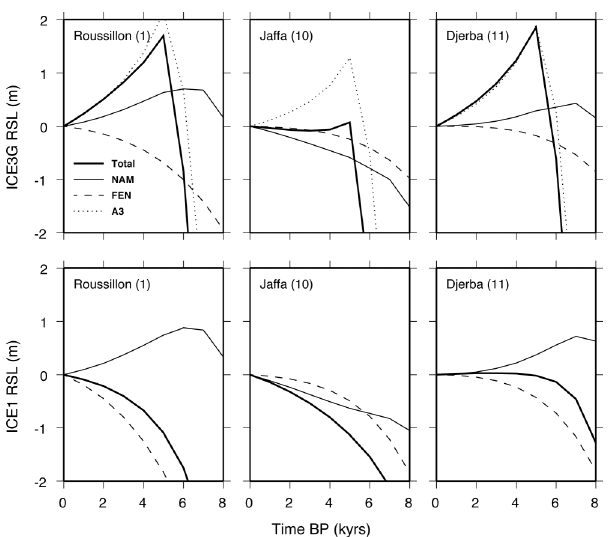
Fig. 7. Contributions to RSL due to individual components of the ICE3G ( top ) and ICE1 ( bottom ) global ice sheets distributions at the sites of Roussillon, Jaffa, and Djerba (see fig.